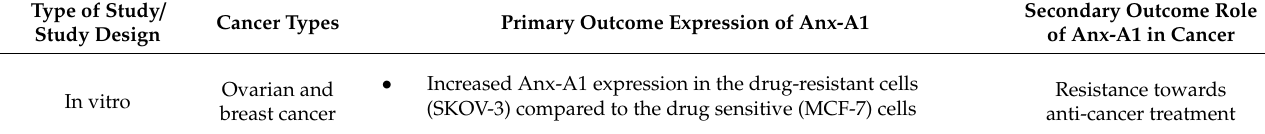
Table 1. Summary findings of the studies included in the systematic